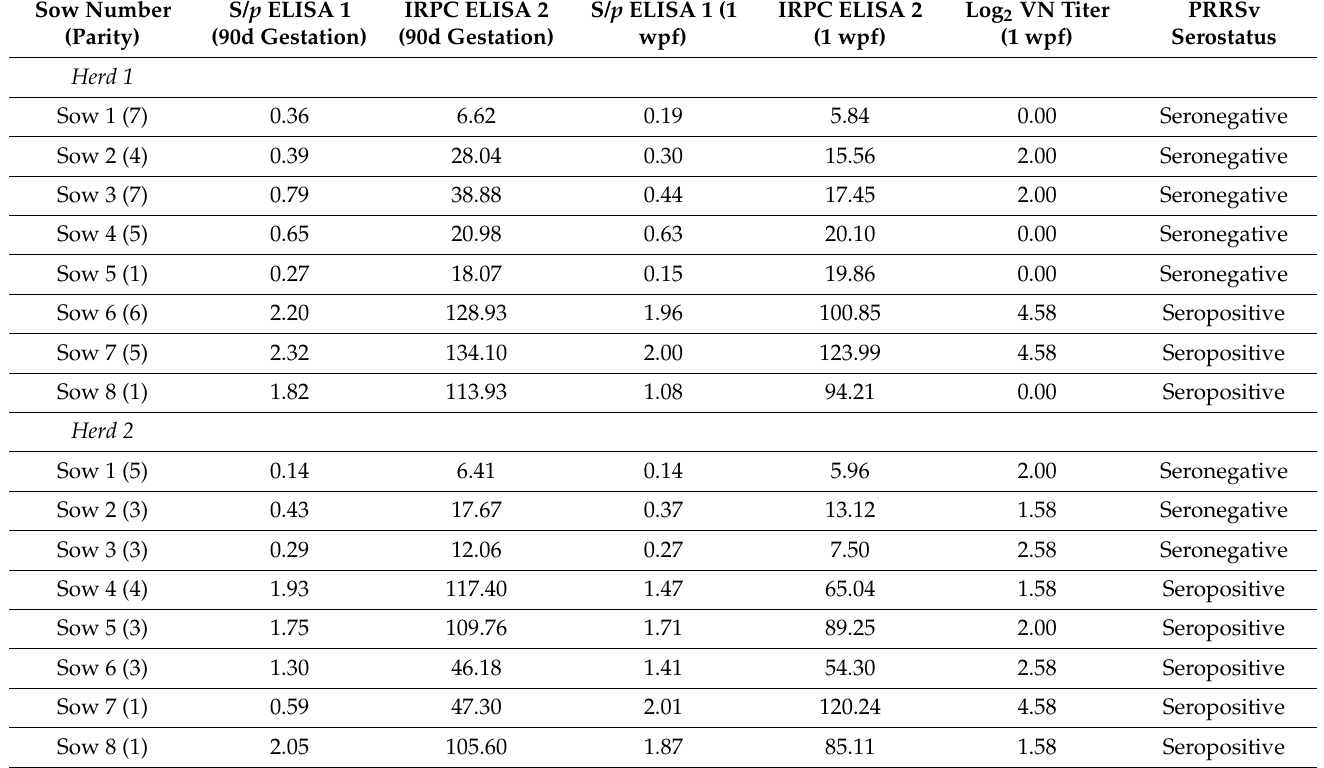
Table 2. Overview of the selected PRRSv-vaccinated sows in two Belgian farrow-to-finish herds. Selected sows were blood-sampled at 90 days of gestation (1 month after the last PRRSv vaccination) and at 1 week post-farrowing (1 wpf). The sows were analyzed using IDEXX ELISA (ELISA 1), CIVTEST ELISA (ELISA 2) and virus neutralization assay (VN). Each sow was given a PRRSv serostatus based on the ELISA results of the second sampling (1 wpf).